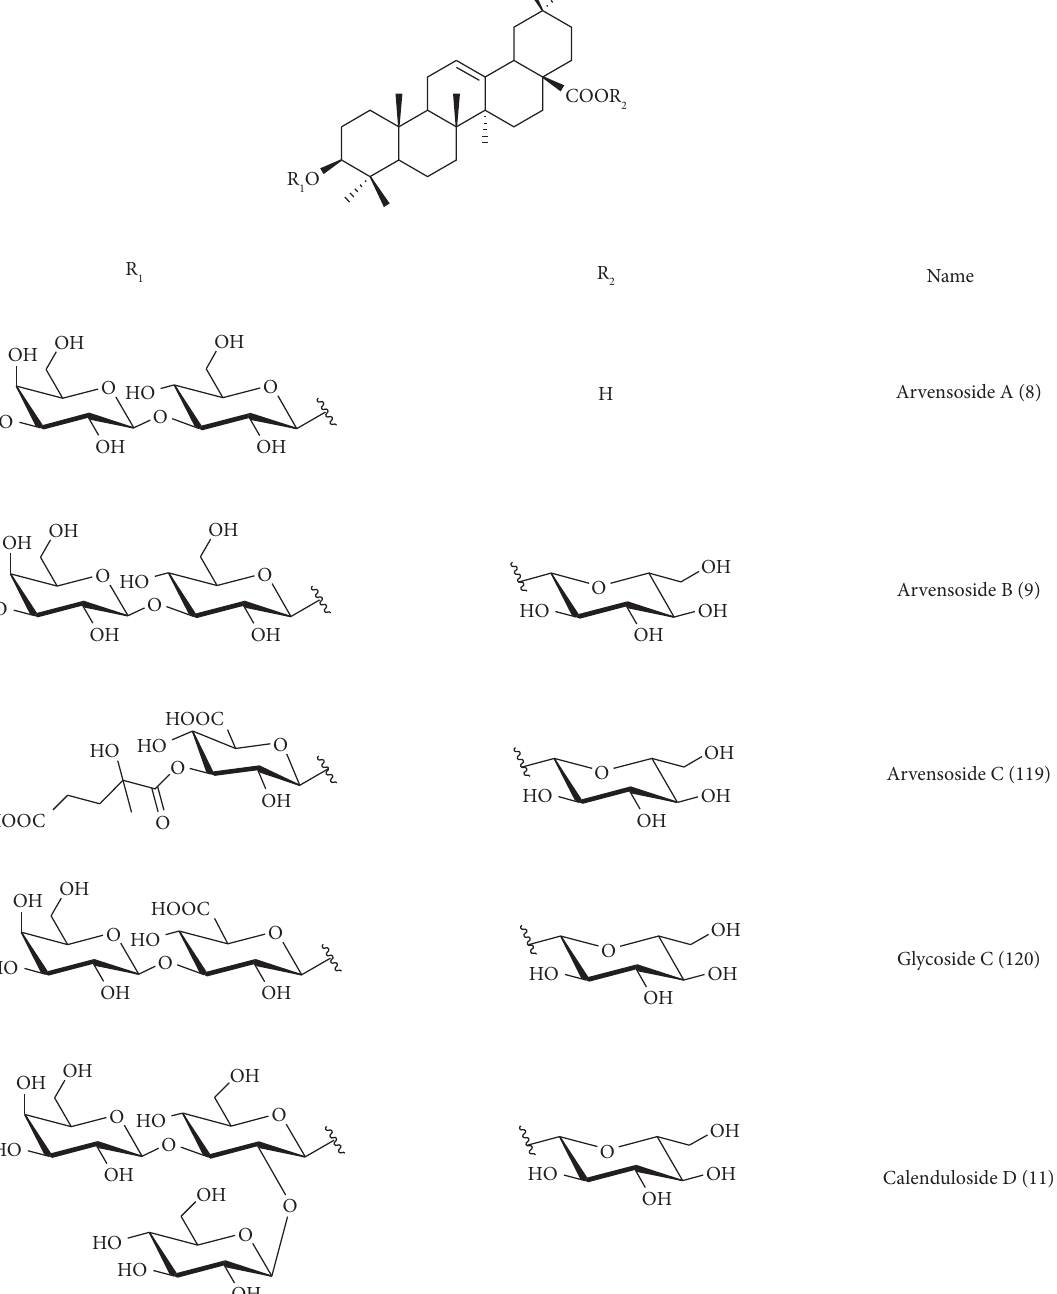
Te GC-MS and GC-FID analysis of C. arvensis EO